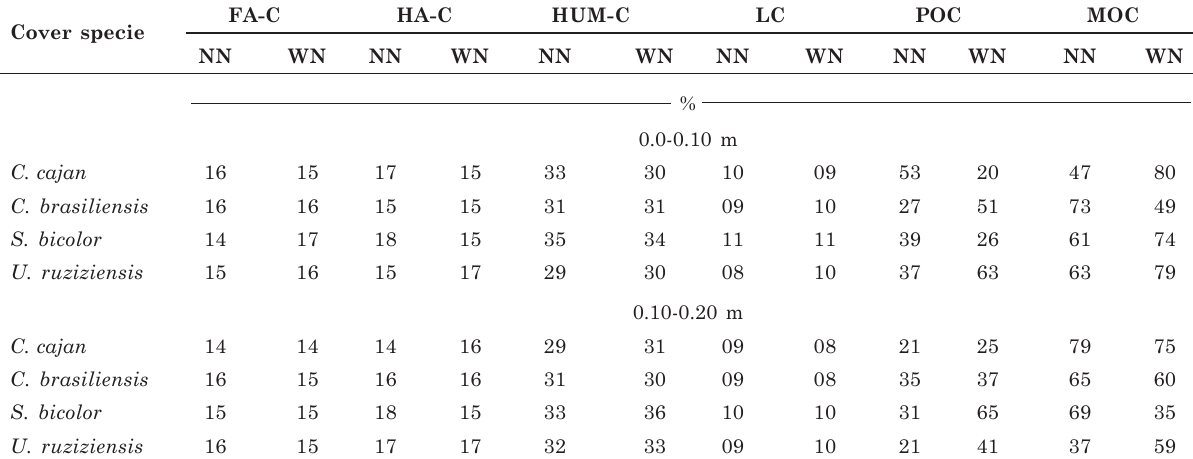
Table 4. Carbon relative to the total organic carbon (TOC) of organic carbon fraction of fulvic acids (FA-C), humic acid (HA-C), humin (HUM-C), labile carbon (LC), particulate organic carbon (POC) and associated minerals (MOC) in Oxisol under cover plants with (WN) and without (NN) of N